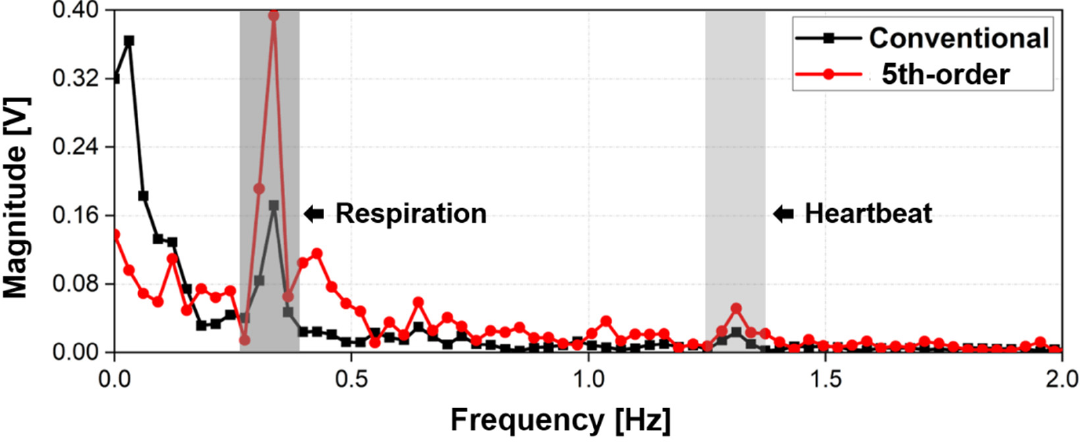
Figure 14. Measurement results of the vital signal detection using the 5.8 GHz CW radar processed by the conventional DC offset cancellation and the proposed detrending technique with the fifth-order polynomial fitting.